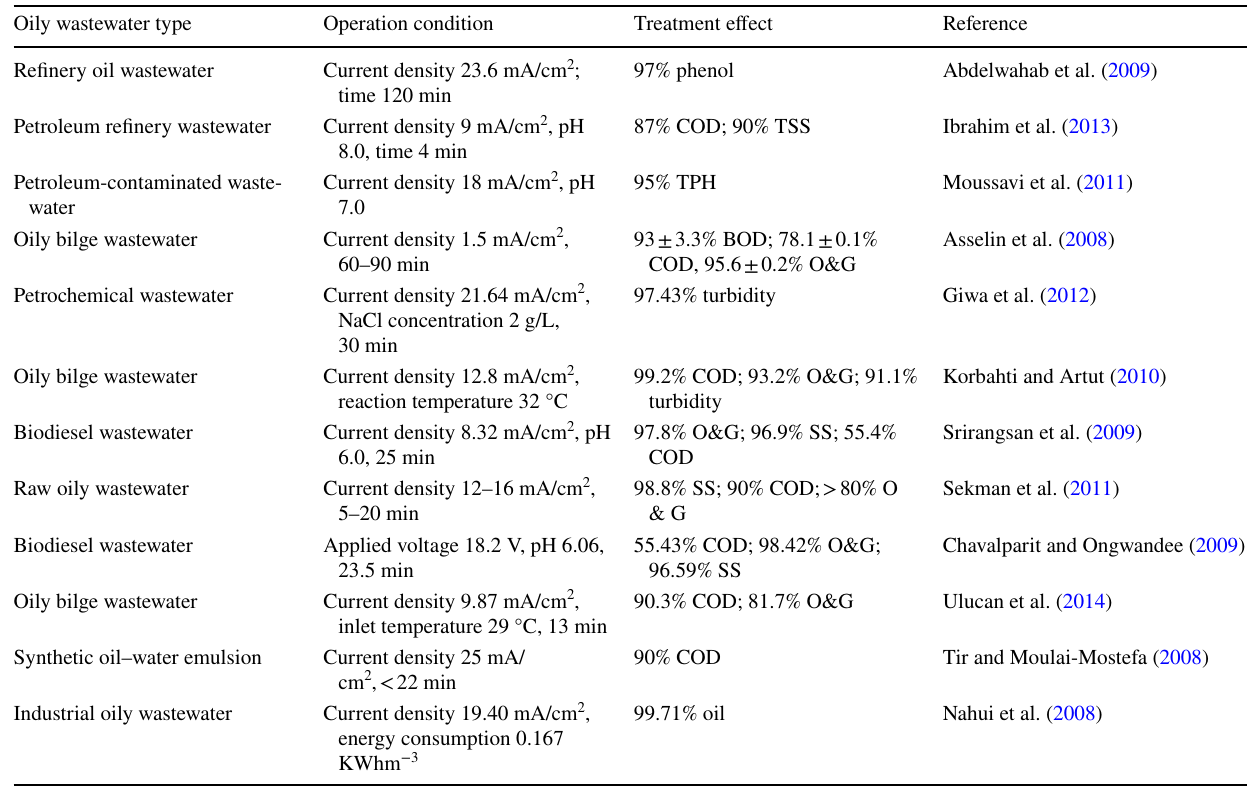
Table 4 Efficiencies of electrochemical technology in the removal of pollutants from oily wastewater Oily wastewater